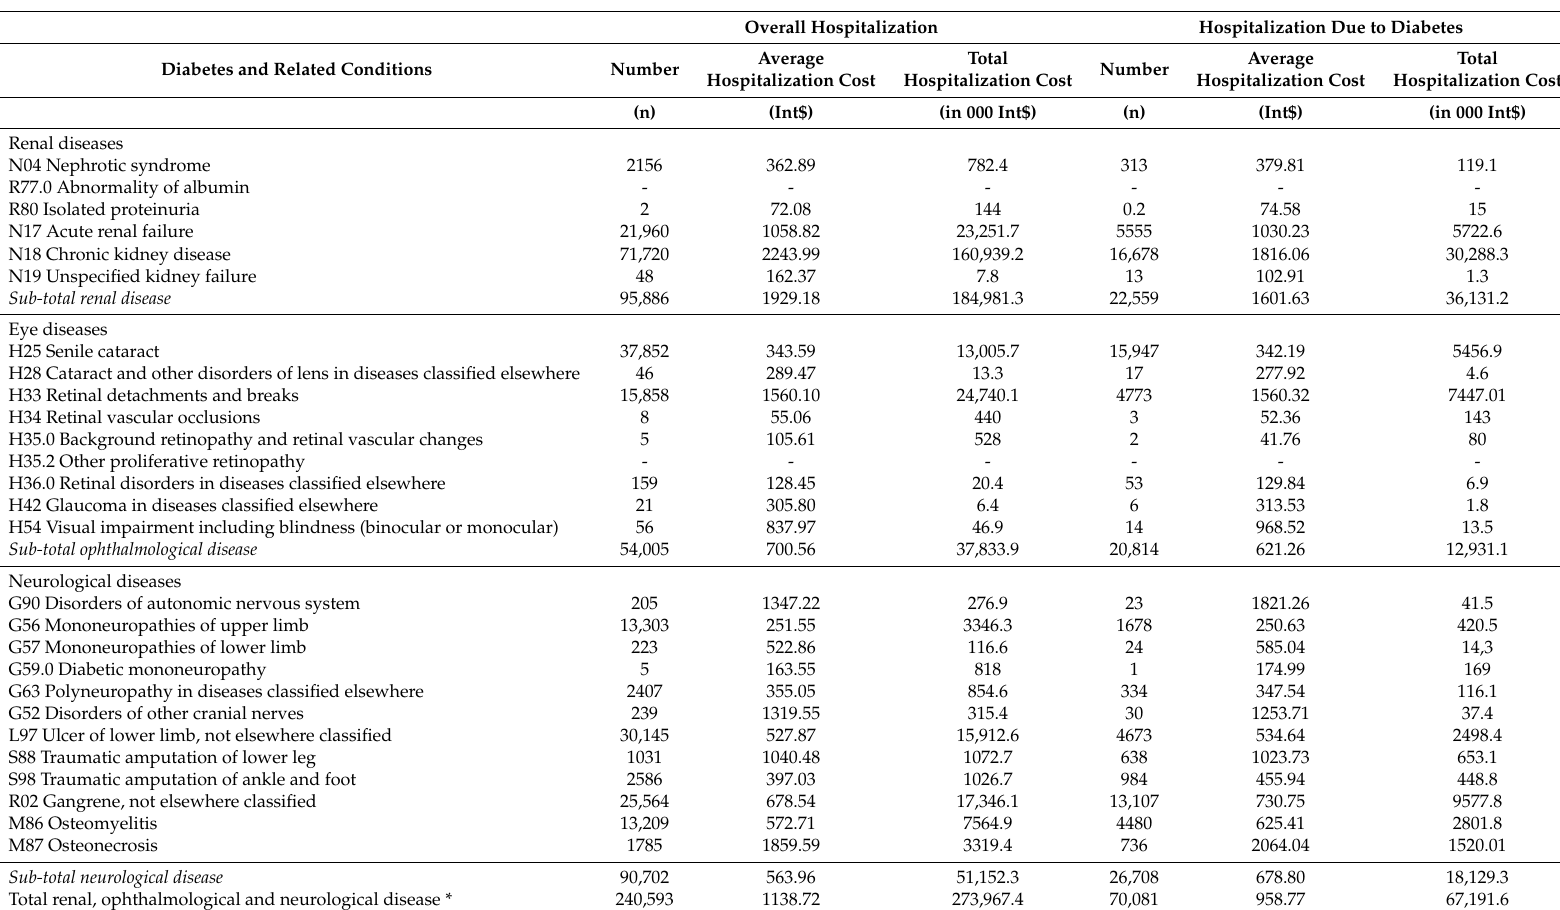
Table 6. Number, average and total hospitalization cost due to renal, ophthalmological and neurological diseases, overall and related to diabetes microvascular complications, adults (20+ years), SUS, Brazil,